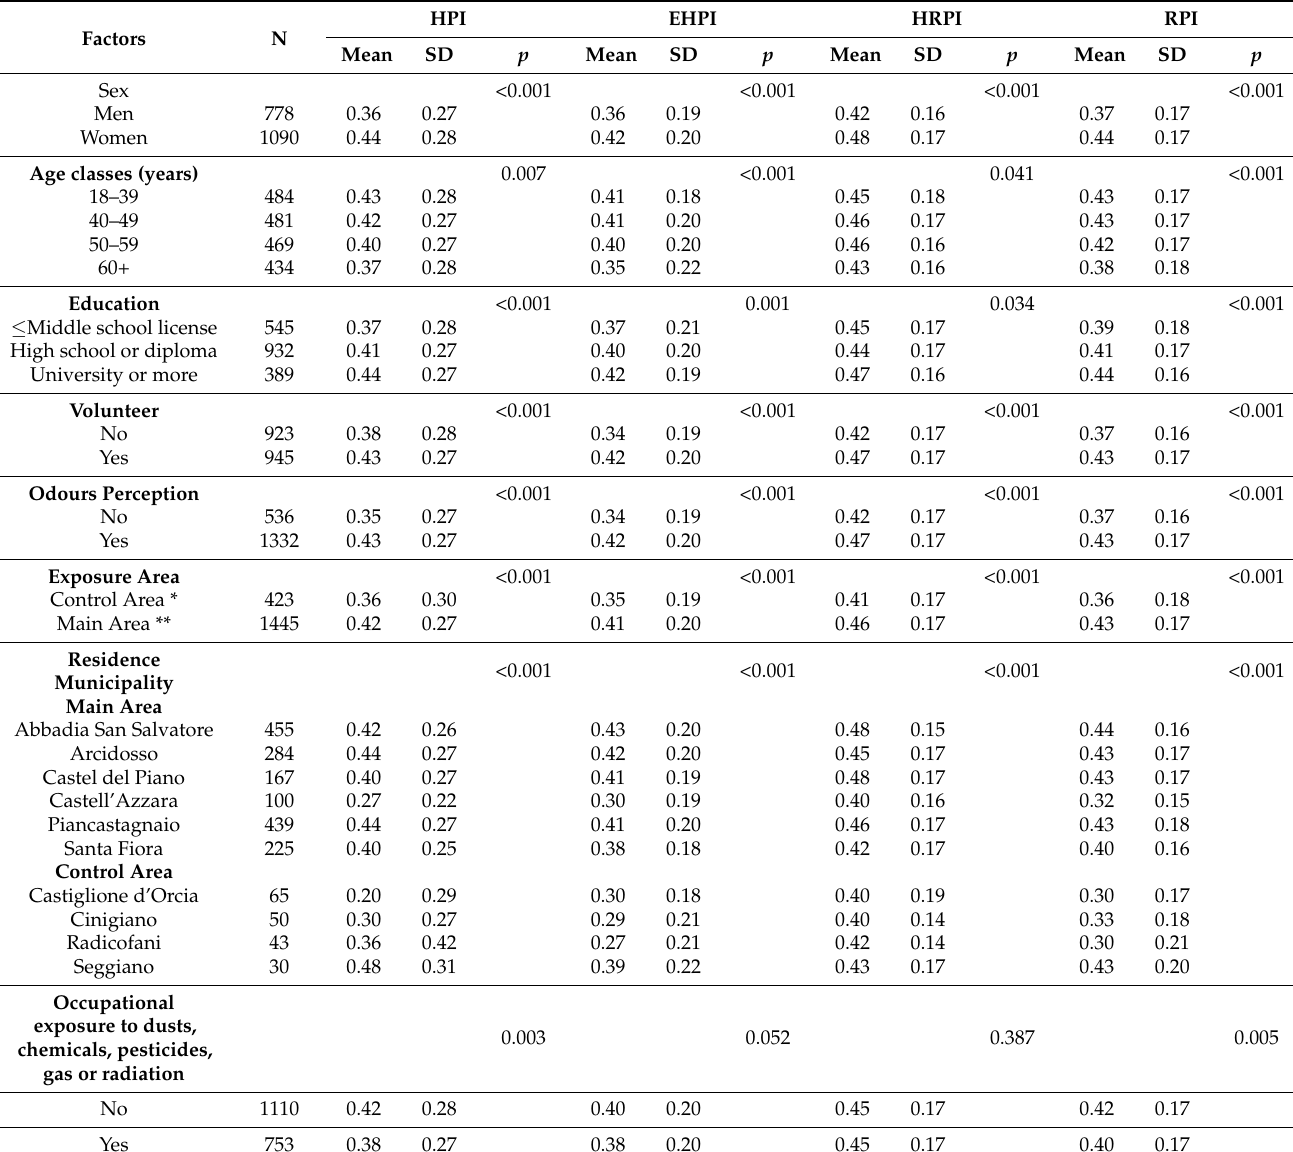
Table 5. Descriptive statistics of the perception indices by gender, age classes, educational level in 3 classes, volunteer or not, odours presence/absence, main area/control area, residence municipalities and occupational exposure to dust, chemicals, pesticides, gas or